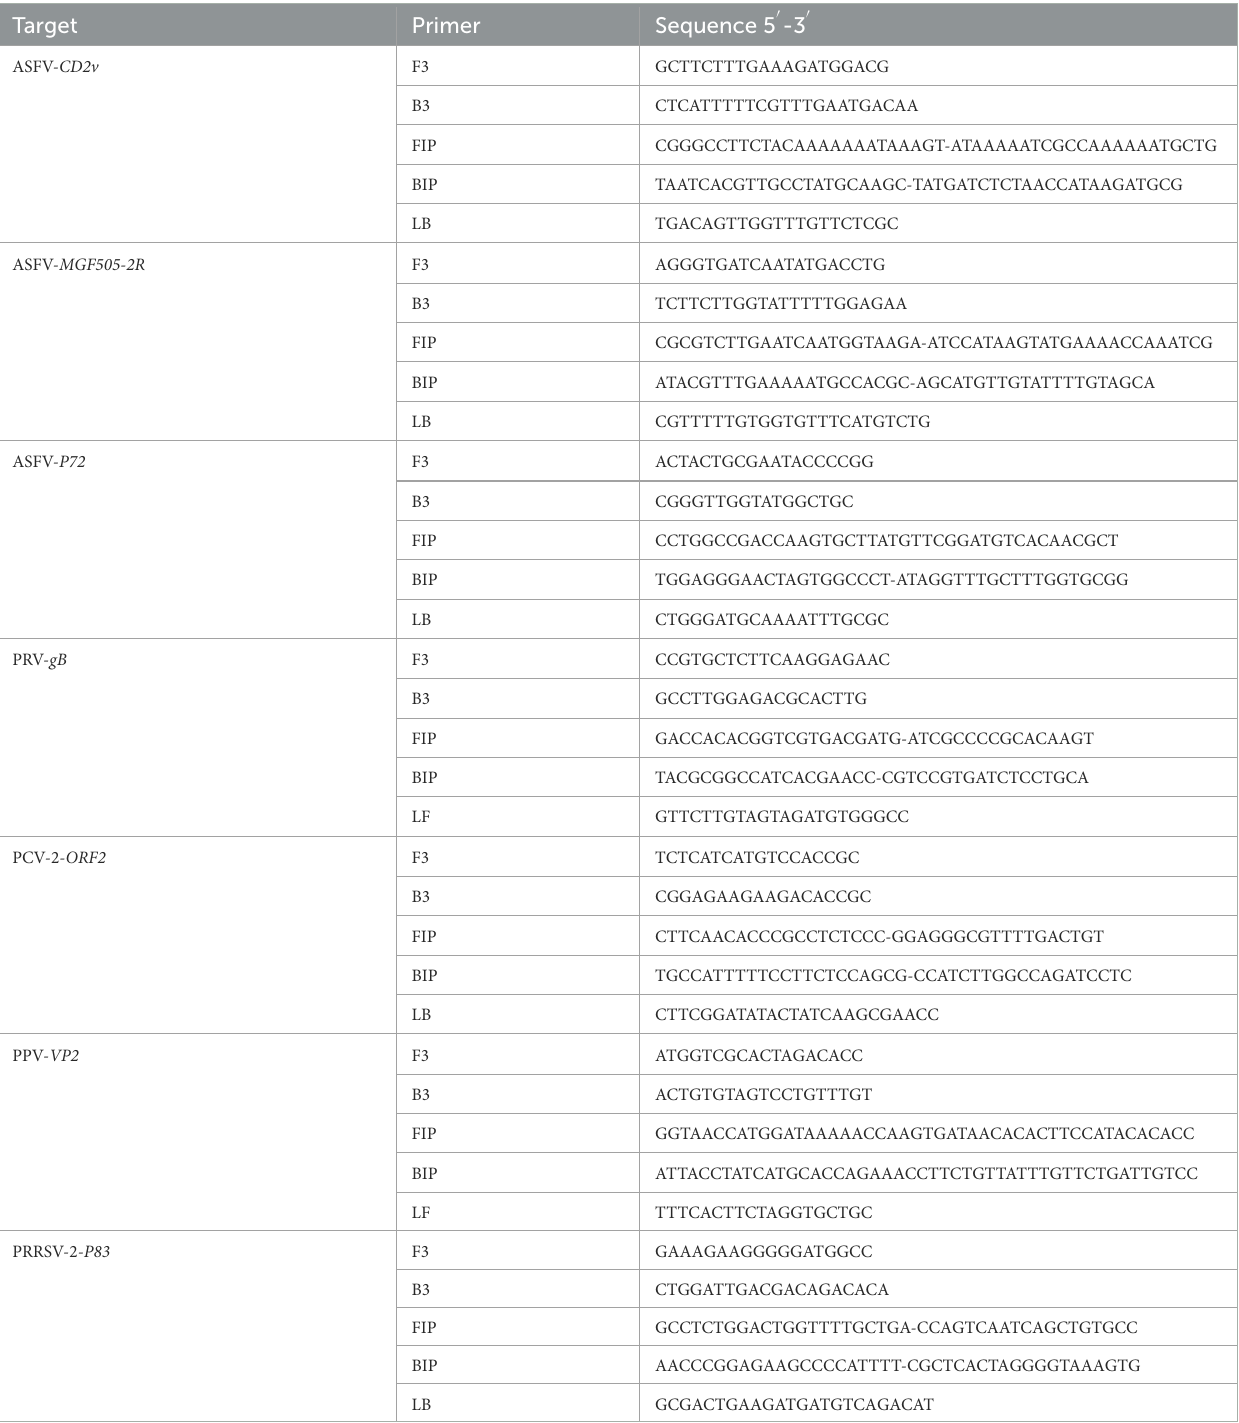
TABLE 1 Primer sequences used in microfluidic-LAMP chip